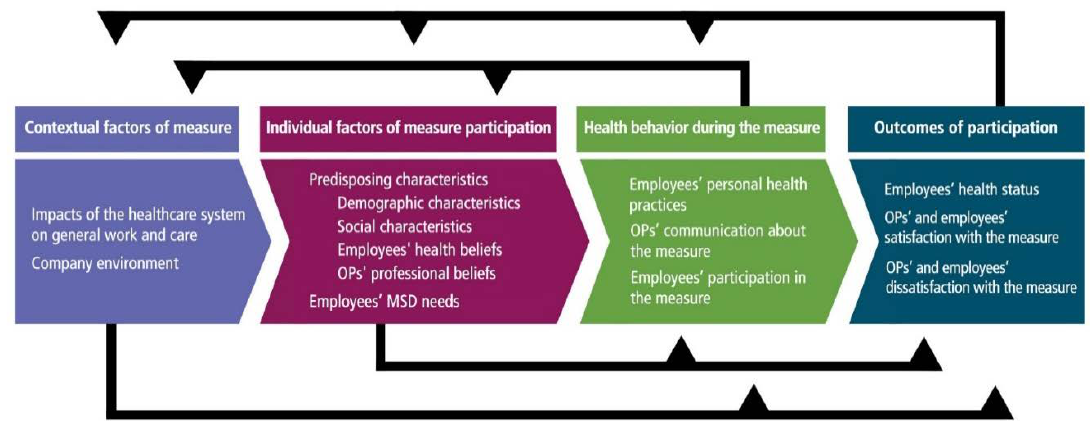
Figure 1. Developed categories based on Andersen’s model of health services use. OPs: Occupational Physicians; MSD: Musculoskeletal Disorders.